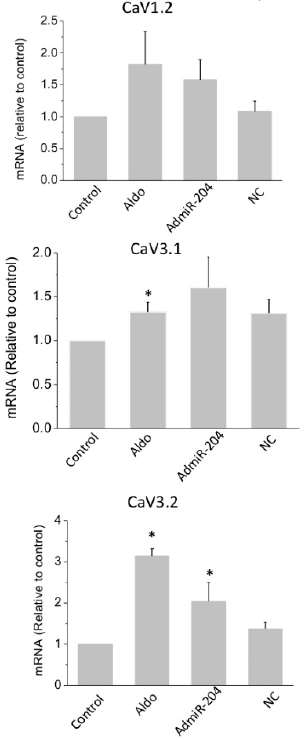
Figure 3. Overexpression of miR-204 increases the expression of calcium channel alpha1 subunits. The mRNA levels for L-type and T-type Ca 2+ channel pore subunits CaV1.2, CaV3.1, and CaV3.2 was determined in control cells and in aldosterone (aldo, 1 µ M for 24 h)-treated, miR-204 adenovirus-infected (AdmiR-204), or shLuc adenovirus-infected cardiomyocytes (NC). Bars and error bars indicate the means + SEMs ( n = 3). * means p < 0.05 vs.